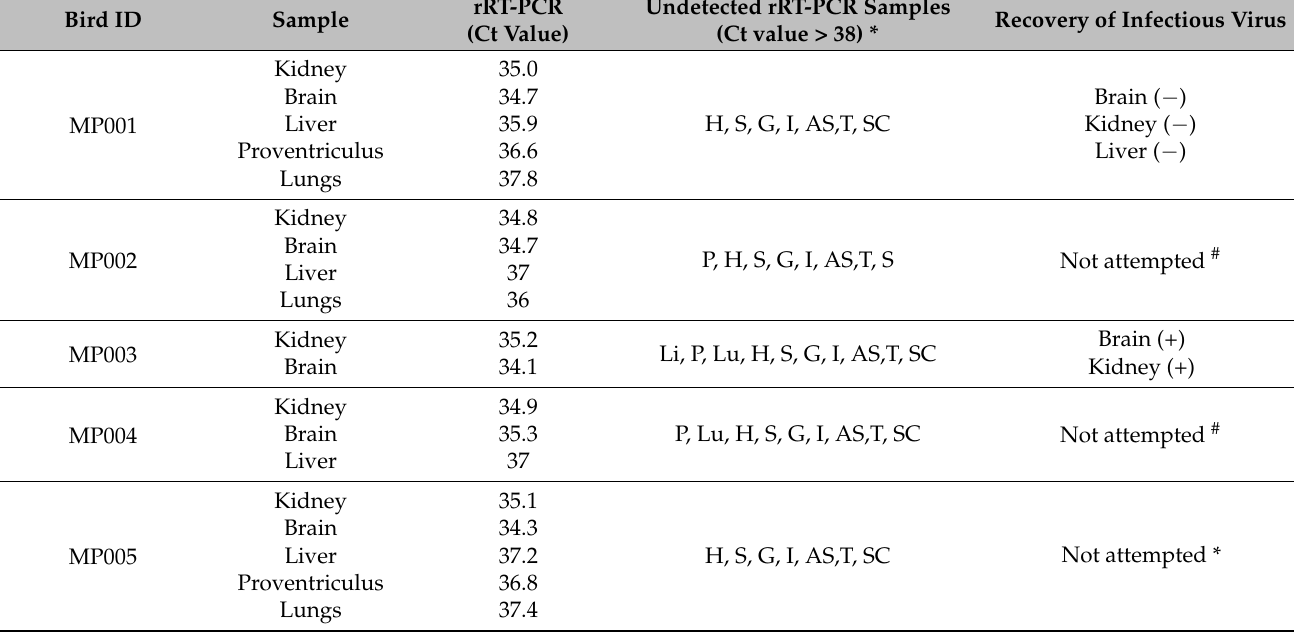
Table 1. Description of collected birds and rRT-PCR processed samples. Samples with a Ct (cycle threshold) below 38 were considered positive for APMV-1. H, heart; L, liver; Lu, lungs; S, spleen; P, proventriculus; G, gizzard; I, intestine; AS, air sac; T, trachea; SC, spinal cord; K, kidney; Ct, cycle threshold. * Samples with a Ct result above 38 were considered negative or undetected. # Not attempted = insufficient sample available to perform virus